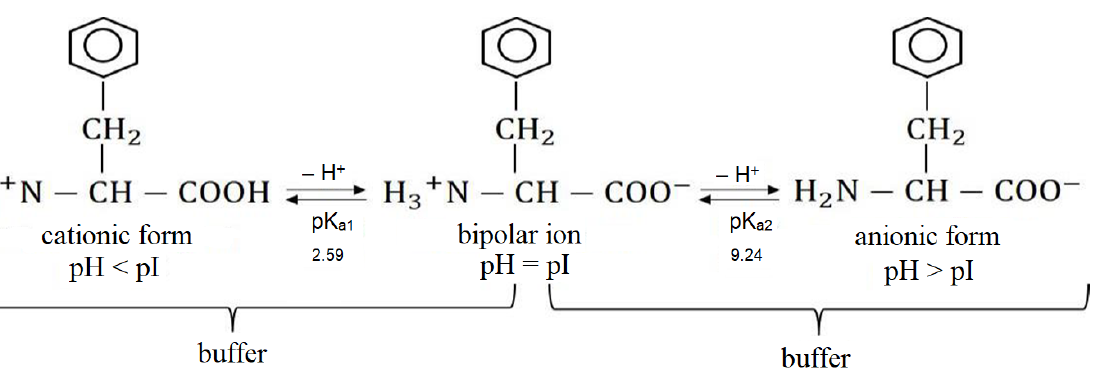
Figure 4. Scheme of the buffering action of phenylalanine during acidification (pH < pI) and alkalization (pH > pI) of the solution.